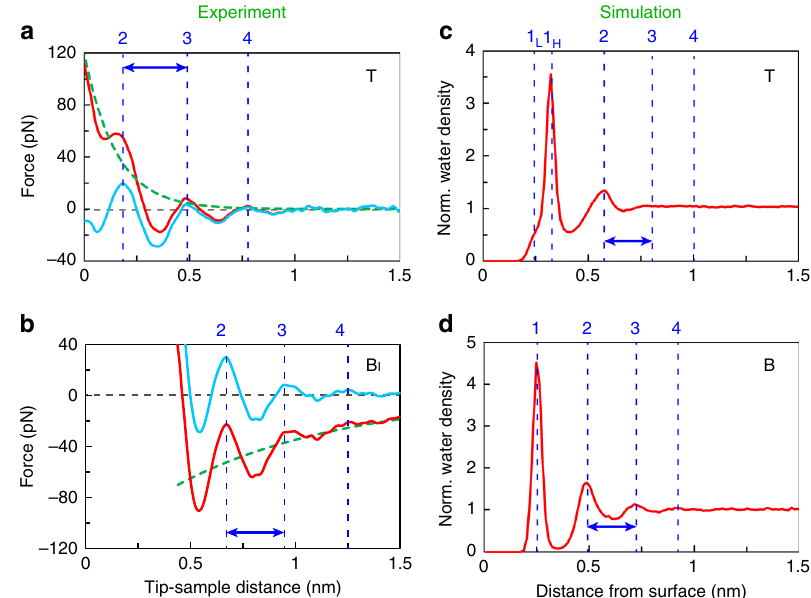
Fig. 3 Comparison of force curves and density pro fi les. a , b Average force pro fi les on the T ( a ) and B I ( b ) regions extracted from 3D force map (red curves). The broken green and solid light-blue curves are the fi tted background force and subtracted force curves, respectively. The vertical blue broken lines represent the force maxima in the subtracted curves. c , d Normalised water (oxygen) and ion density pro fi les calculated by MD simulation on the T ( c ) and B ( d ) regions